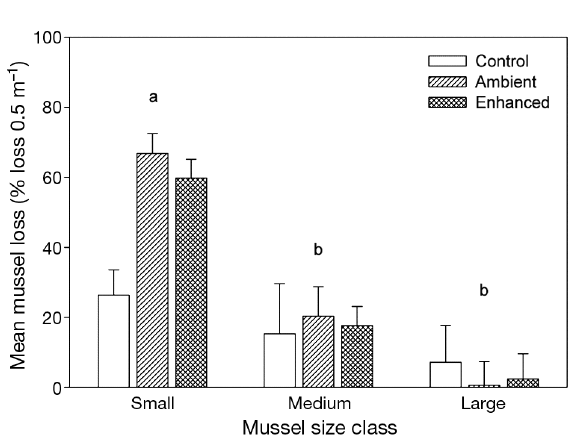
Fig. 4. Perna canaliculus . Mean mussel loss (+SE, n = 10 for ambient and enhanced treatments, and n = 5 for controls, except for large size class with ambient treatment: n = 8, and Fig. 5. Perna canaliculus and Didemnum vexillum . Relation- large size class with control treatment: n = 4) per 0.5 m sec- ship between mussel density and D. vexillum biomass tion of line for 3 size classes (small: 20−40 mm shell length at per 0.5 m section for the (a) small (20−40 mm shell length deployment, medium: 40−60 mm, and large: 60−70 mm) and at deployment), (b) medium (40−60 mm), and (c) large 3 fouling treatments (controls, ambient fouling, and en- (60−70 mm) size classes of mussels in the ambient fouling ( s ) hanced Didemnum vexillum fouling). Size classes sharing a and enhanced D. vexillum fouling ( d ) treatments. The 95% letter indicate groupings from pairwise comparisons that confidence intervals are shown (-----). Note the differences were not significantly different from each other ( t -statistic, in scales on the x - and y p > 0.05)